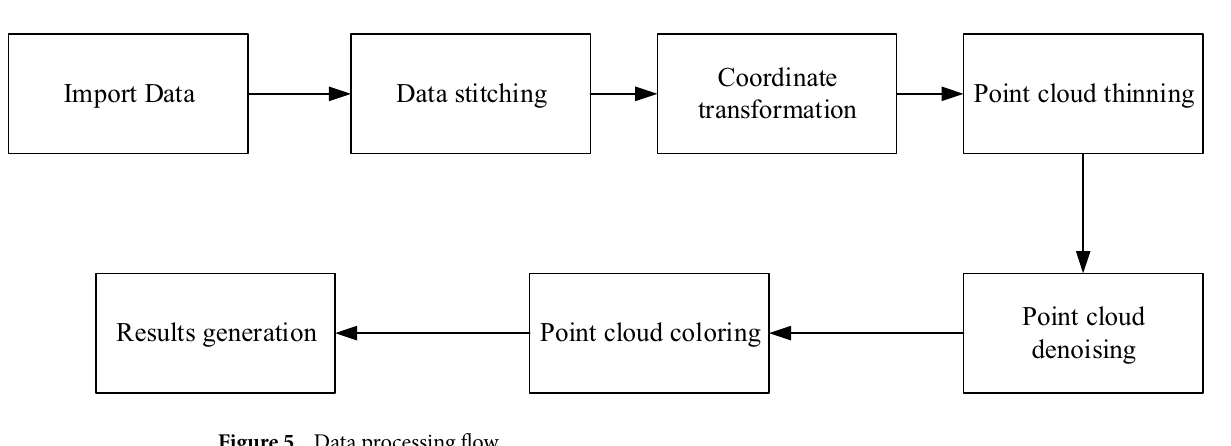
Figure 4. Data collection process.